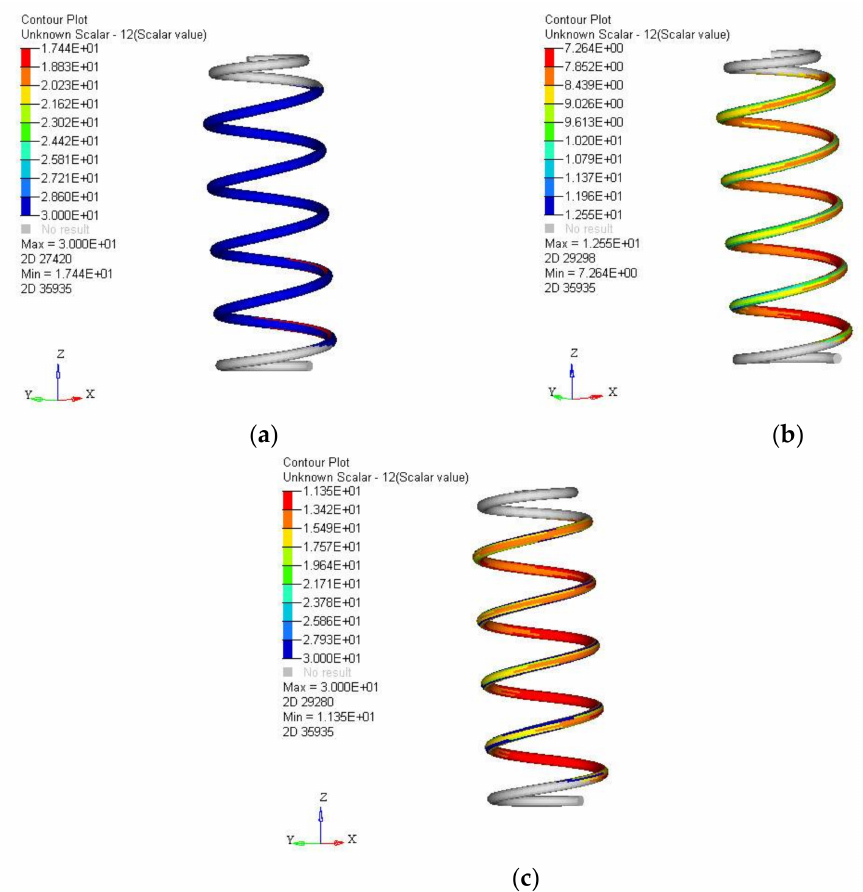
Figure 11. Fatigue life contour plot of spring using Lalanne PSD cycle count and absolute maximum principal stress under different roads: ( a ) highway; ( b ) residential; and, ( c )